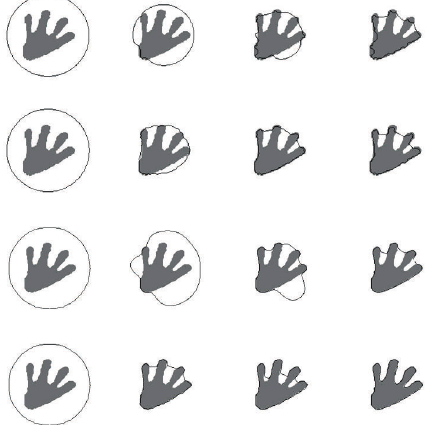
Figure 8: Results on object with multiple deep